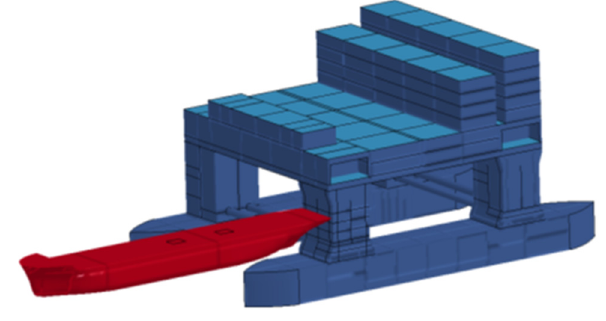
Figure 6. The schematic diagram of the SP1 collision condition.